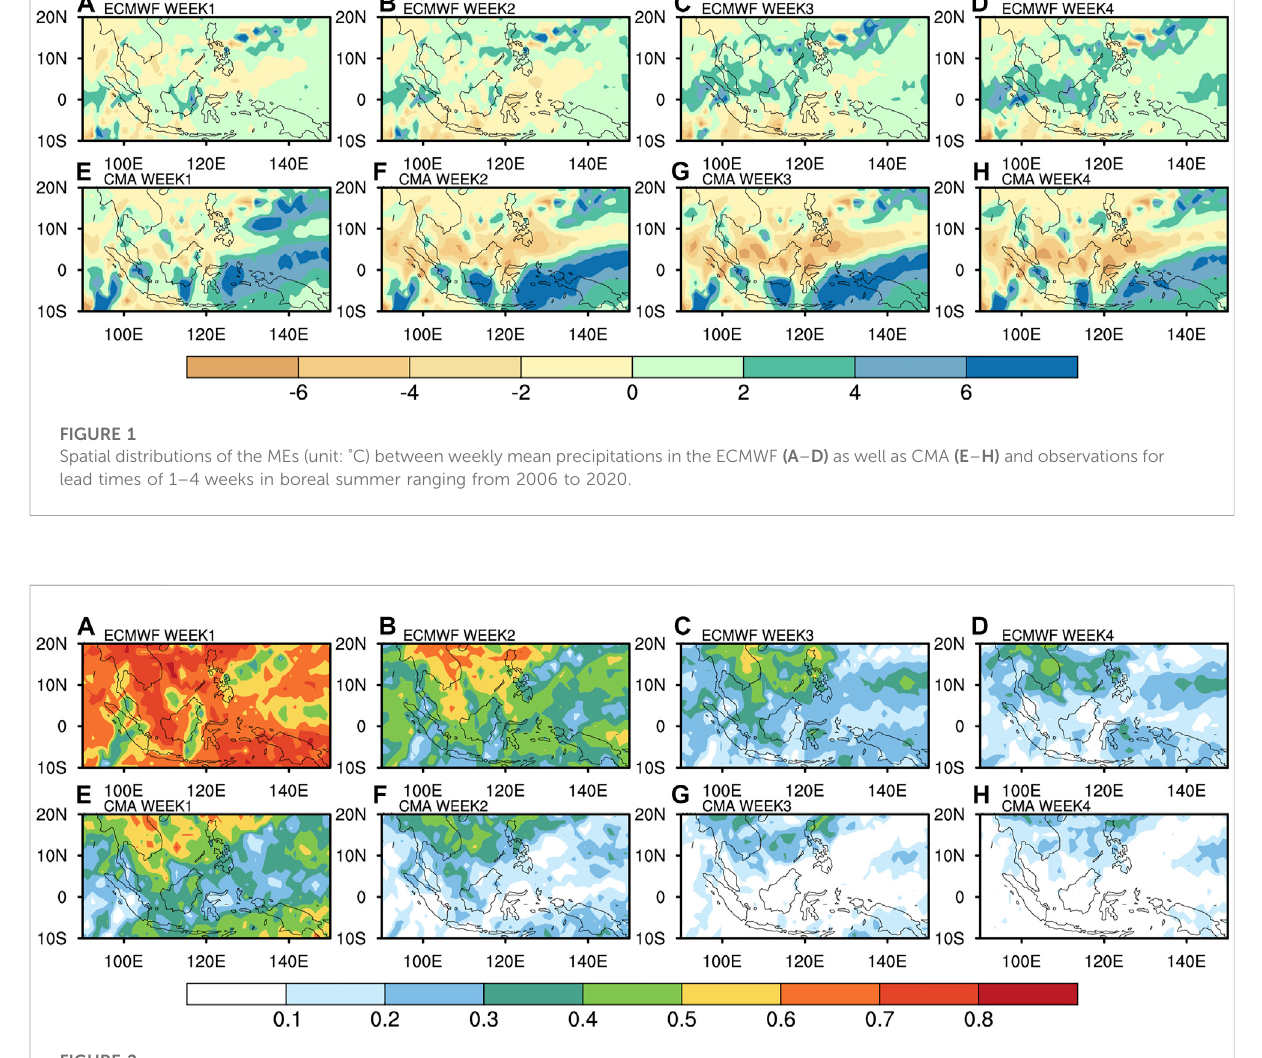
Spatialdistributionsofthetemporalcorrelationcoef fi cientsbetweenweeklymeanprecipitationsintheECMWF (A – D) aswellasCMA (E – H) and observations for lead times of 1 – 4 weeks in boreal summer ranging from 2006 to